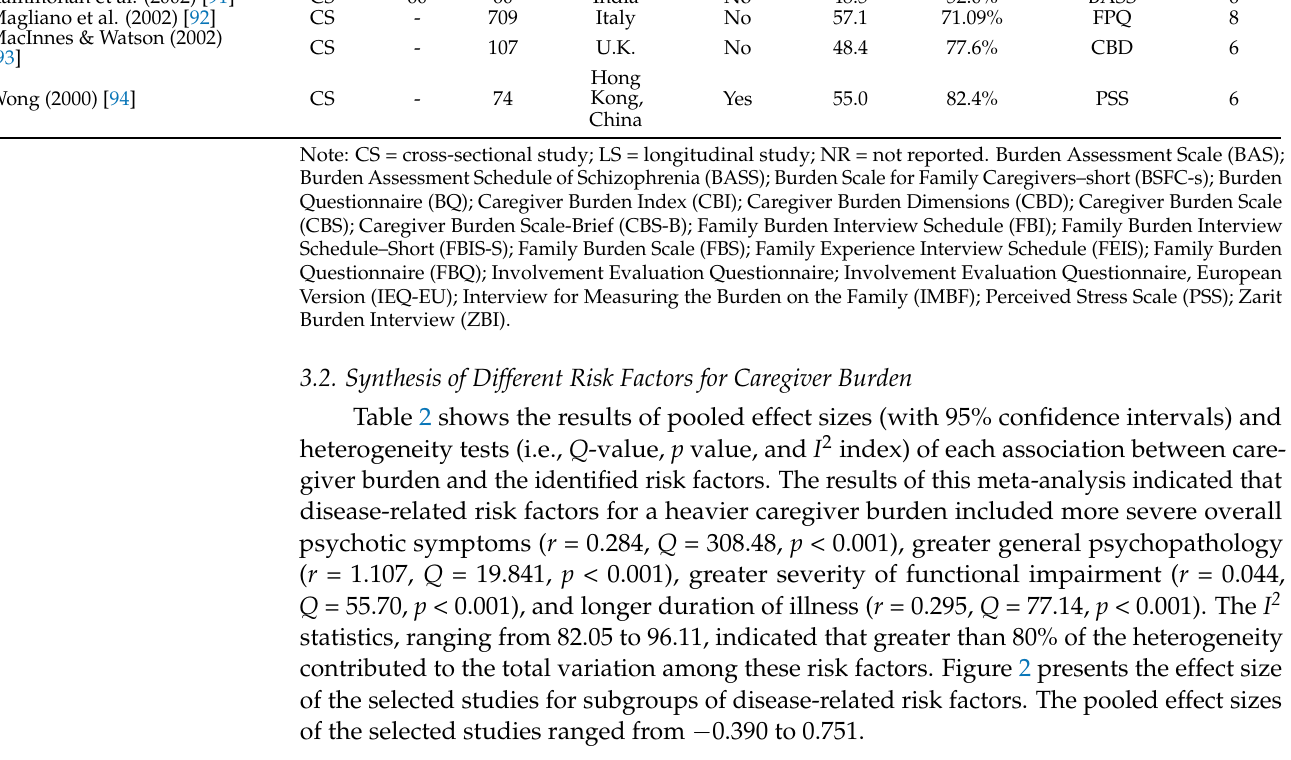
Table 2. Effect sizes of risk factors for caregiver burden in families of persons with